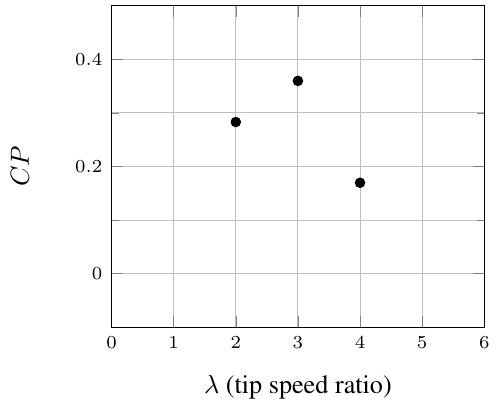
Figure 7. Power coefficient of the fixed pitch turbine as a function of the tip speed ratio ( λ ), U ∞ = 2